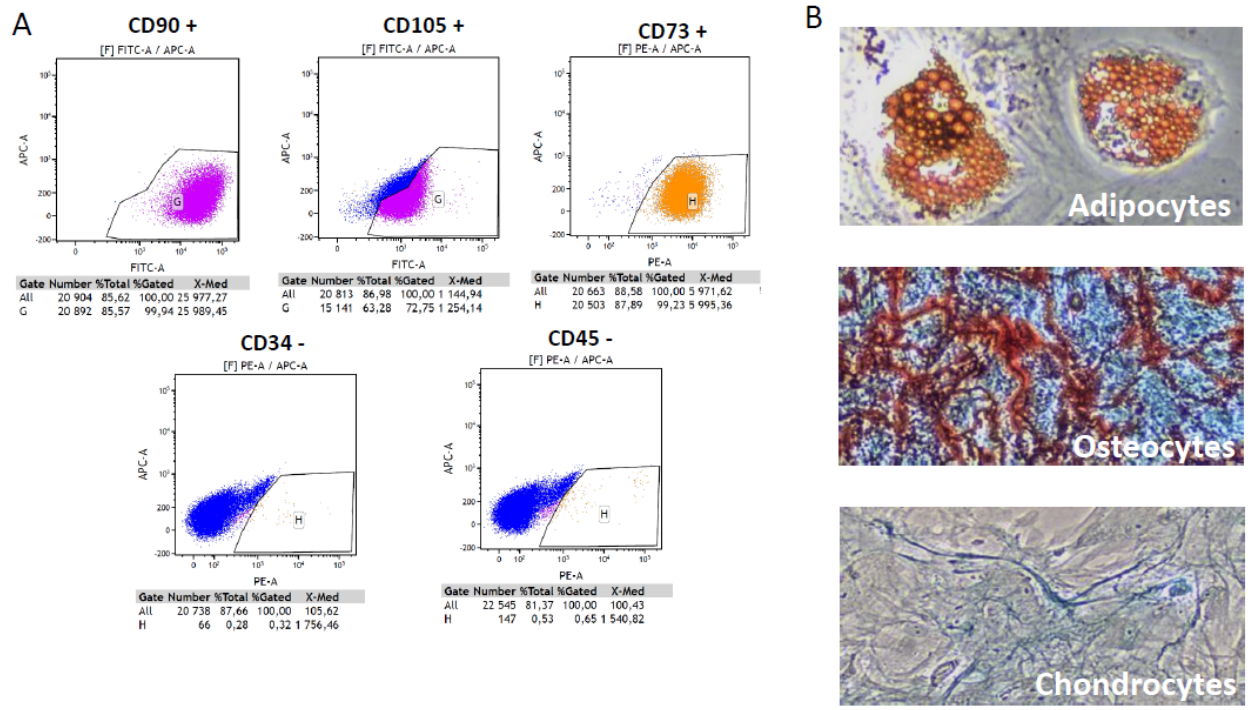
Figure 3. MSC characterization . ( A ) Flow cytometric analysis of MSC cells. The cells at passage 4 were labeled with the CD90−FITC, CD105−FITC, CD73−PE, CD34−PE and CD45−PE antibodies. The cells were positive for CD90, CD105 and CD73, and negative for the hematopoietic markers CD34 and CD45. ( B ) Assays for MSC differentiation. MSCs were cultured with lineage-specific media for 21 days to induce cell differentiation. Differentiation into adipocytes, osteocytes and chondrocytes was detected by Oil Red O, alizarin red and alcian blue, respectively (10× objective).